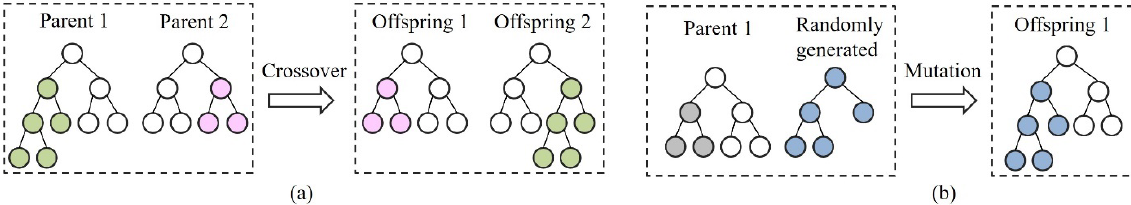
Figure 7. Schematic of crossover ( a ); and mutation operations ( b ).